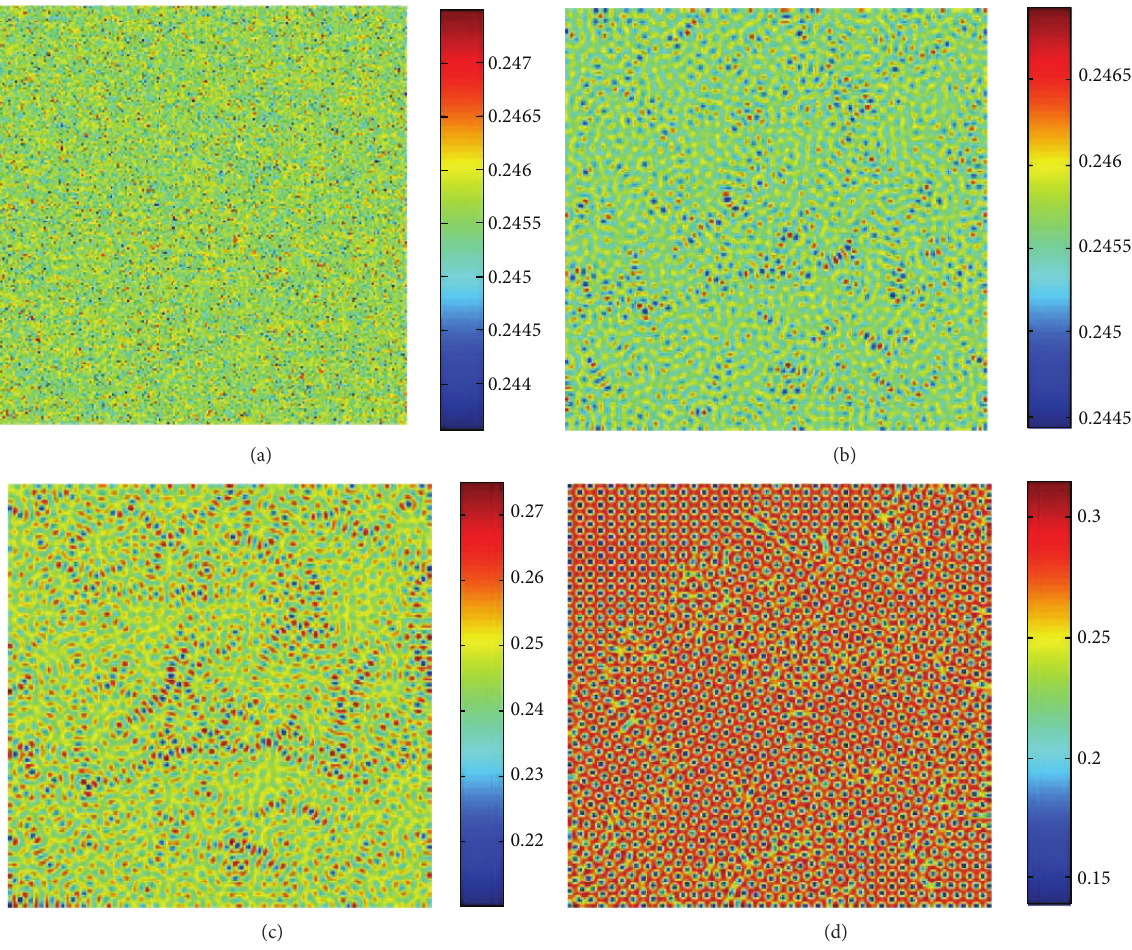
Figure 2: Snapshots of the time evolution of the prey at different instants with 𝛾 = 1 , 𝑑 = 0.08 , 𝑠 = 1.55 , 𝜏 = 0.1 , 𝐷 𝑢 = 0.1 , and 𝐷 V = 3.68 , which are in the Turing space. (a) 0 iteration; (b) 10000 iterations; (c) 50000 iterations; and (d) 300000